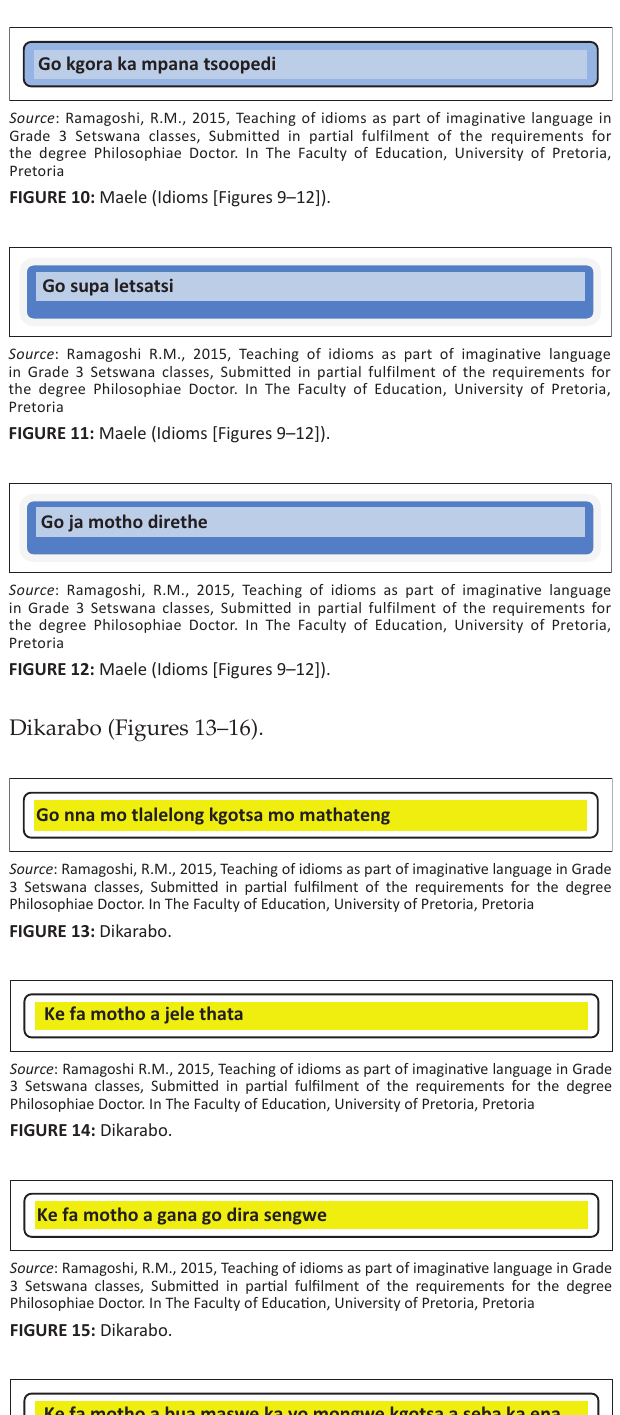
FIGURE 16: Dikarabo.